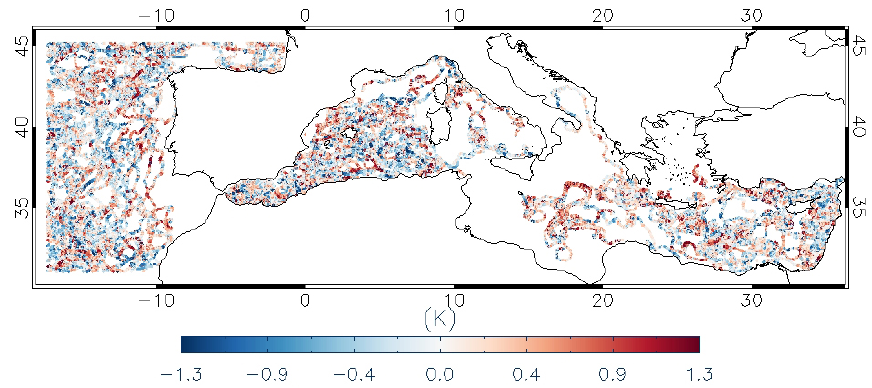
Figure 2. Spatial distribution of the matchup points along with their punctual bias (i.e., SST minus drifter data,K) over the DOISST geographical domain from 1 January 2019 to 31 December 2020. Table 3. Summary statistics of DOISST and MedFS SST. Mean bias (K), RMSD (K), and correlation coefficient are derived from temperature differences against drifters’ data over the period 2019–2020. Each statistical parameter is associated with a 95% confidence interval computed through a bootstrap procedure (Efron and Tibshirani, 1994). Period Mean bias (K) RMSD (K) Correlation coeff. Matchups DOISST 2019-01-01 to